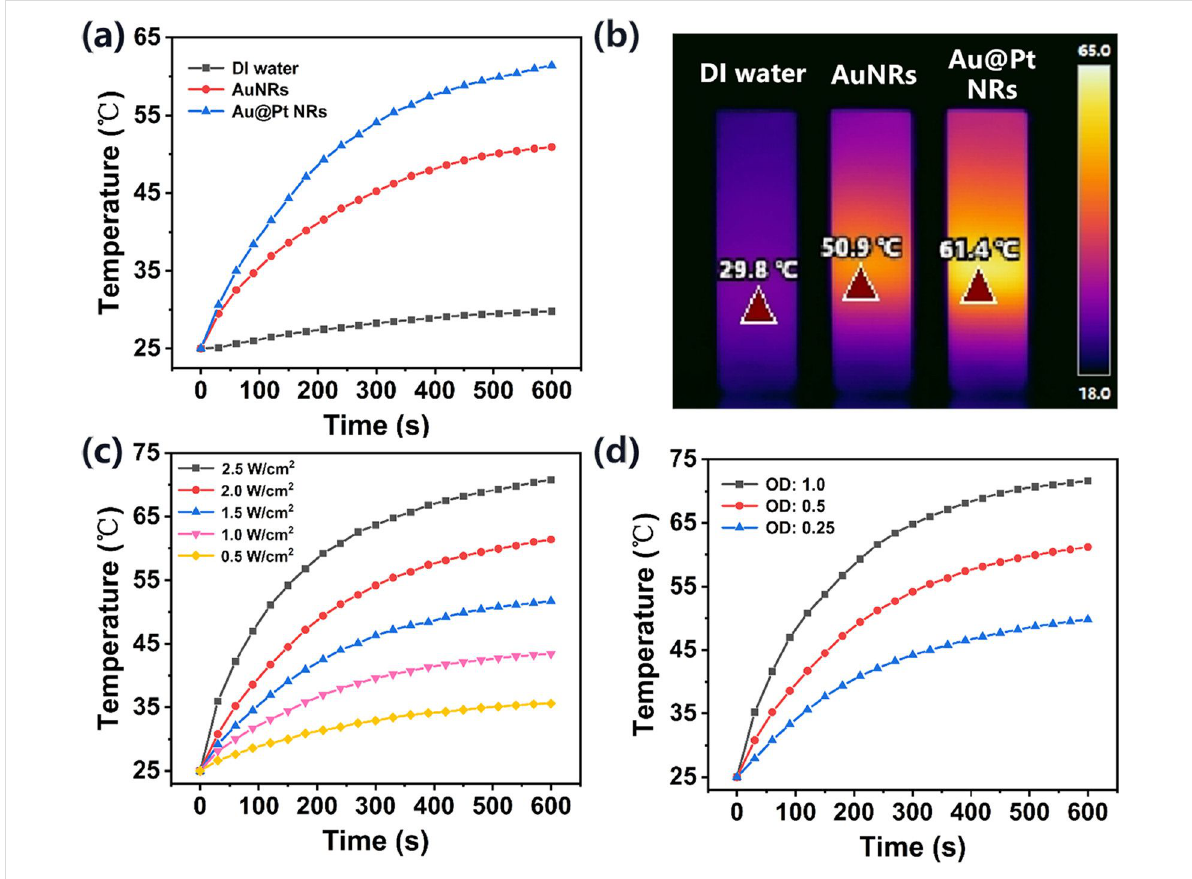
Figure 5: (a) Temperature elevation curves of deionized water (black), AuNRs solution (OD = 0.5, red) and Au@Pt NRs solution (OD = 0.5, blue) upon exposure to 808 nm laser excitation (2 W/cm 2 , 10 min). (b) Infrared thermal images of the three solutions after 600 s of laser exposure. (c) Tem- perature elevation curves of Au@Pt NRs solution (OD = 0.5) under different laser power densities (10 min). (d) Temperature elevation curves of Au@Pt NRs solution with different OD under 808 nm laser irradiation (2.0 W/cm 2 , 10